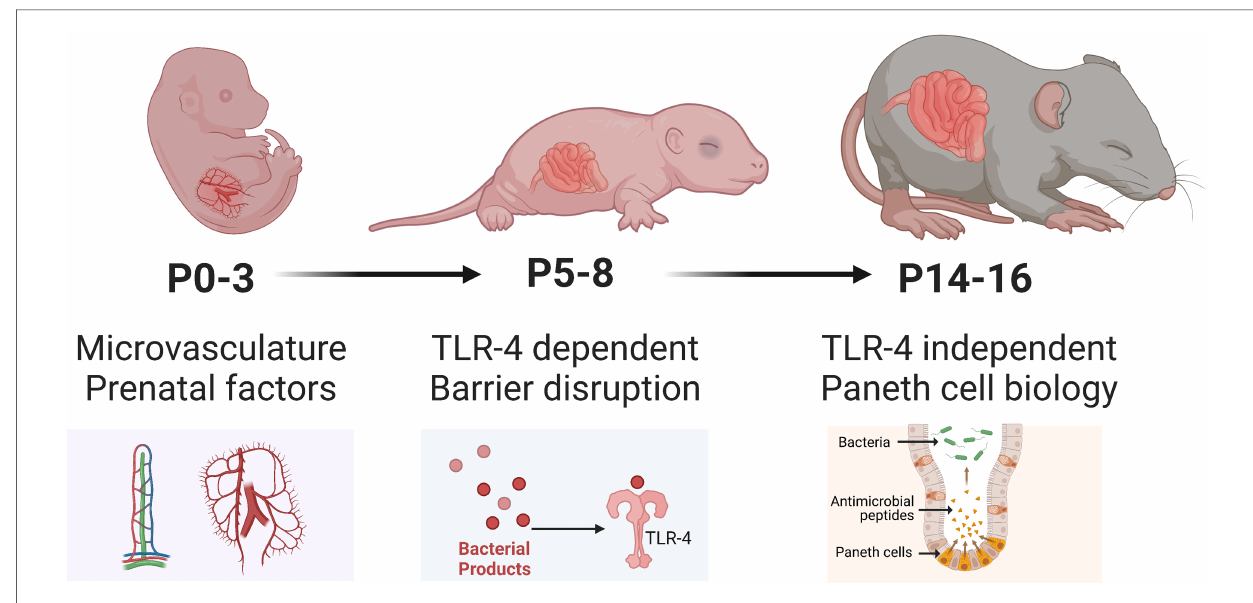
FIGURE 3 Developmental considerations of mice used to model NEC. Illustration created on